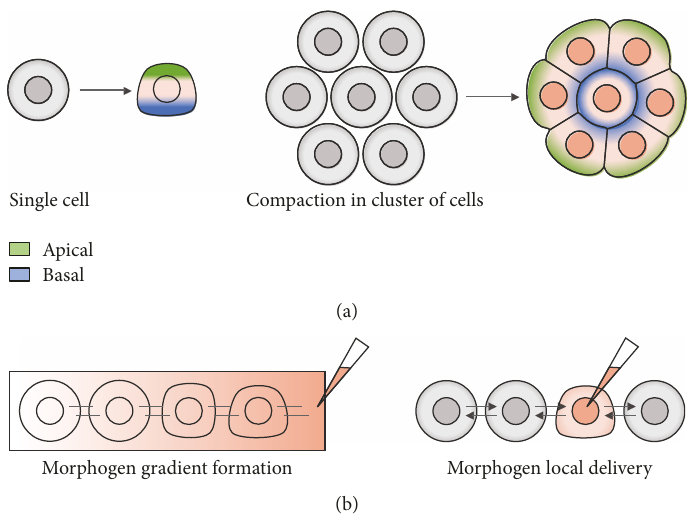
Figure 3: Symmetry breaking process. (a) Symmetry breaking in vivo is observed at the single-cell level and multicellular level, involving a process of compaction. (b) Di ff erent approaches for symmetry breaking in vitro , using micro fl uidic approaches to create a morphogen gradient or local delivery of